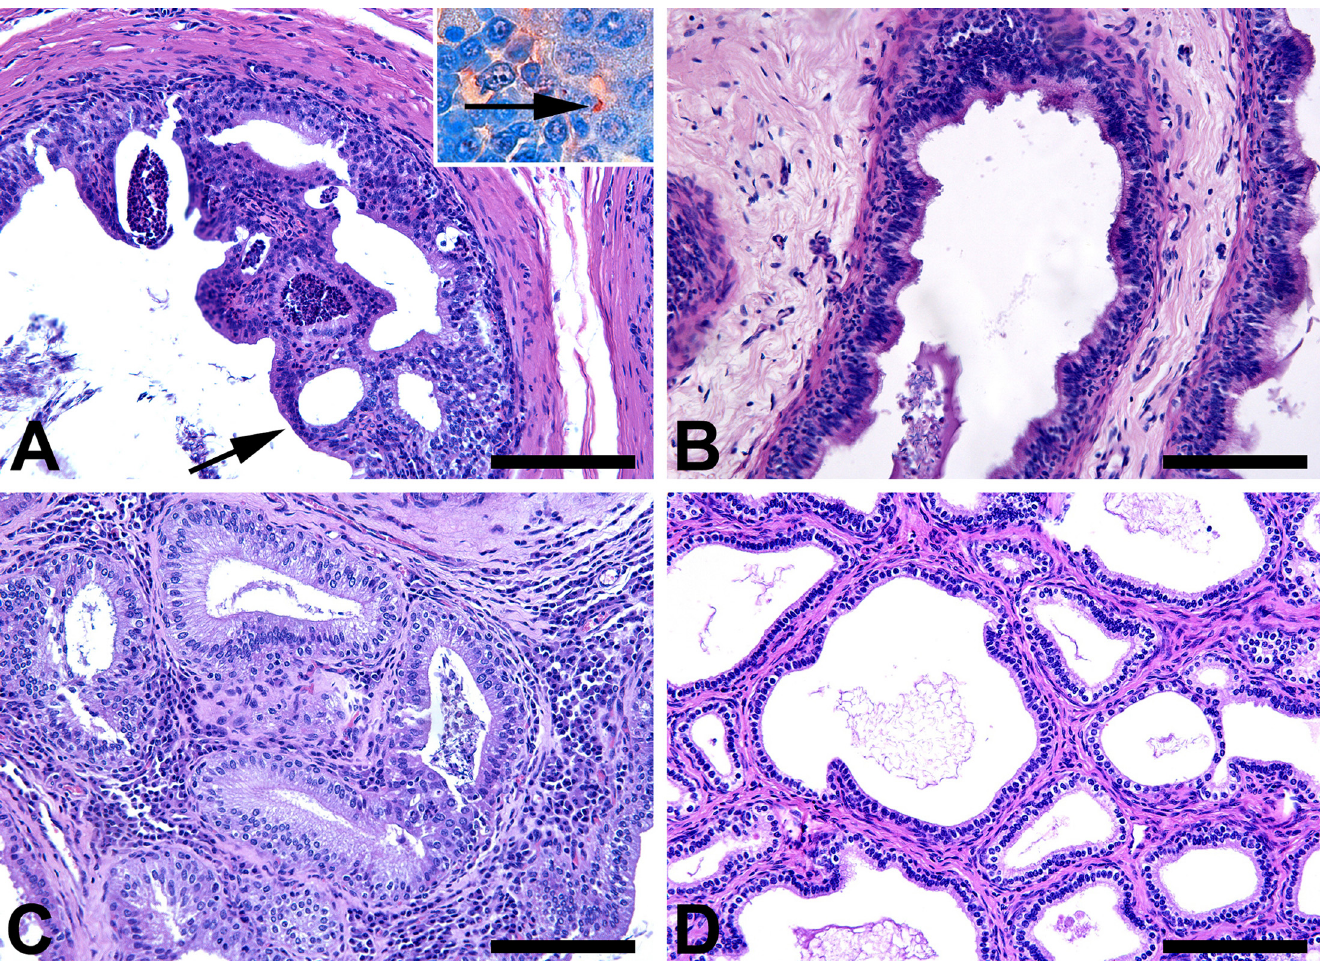
Fig 8. Microscopic changes in the reproductive system of non immunized rams experimentally challenged with Brucella ovis , at 8 weeks post challenge. Severe neutrophilic epididymitis associated to cystic epithelium degeneration (black arrow), with positive immunestaining for B . ovis (inset, 100X) in the tail of the epididymis from a non immunized ram (A). Tail of the epididymis from a ram immunized with encapsulated B . ovis Δ abcBA and challenged with wild type B . ovis with no histological changes (B). Moderate lympho-histiocytic and neutrophilic inflammatory infiltrate in the ampullae of a non immunized ram (C). Absence of histological changes in the ampullae of a ram immunized with encapsulated B . ovis Δ abcBA and challenged with wild type B . ovis (D), H. E. Bar = 50 μ m.